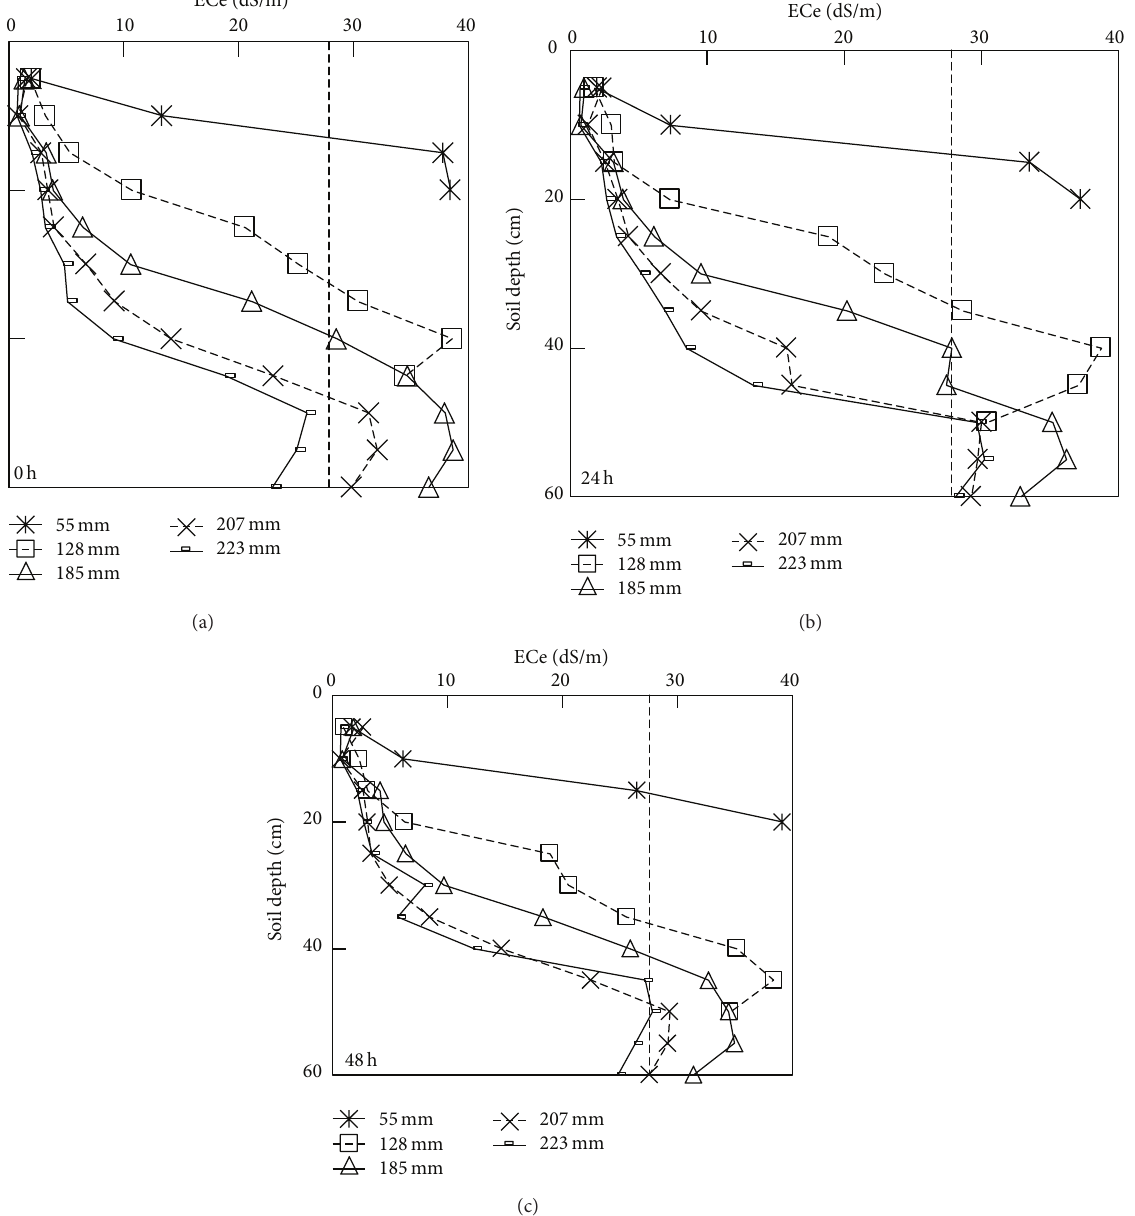
Figure 3: The depth distributions of ECe at 0 hour (a), 24 hours (b), and 48 hours (c) during water redistribution under different water amounts